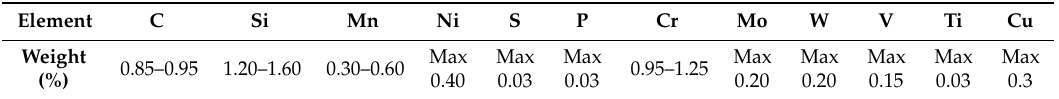
Table 1. Chemical composition of 90CrSi